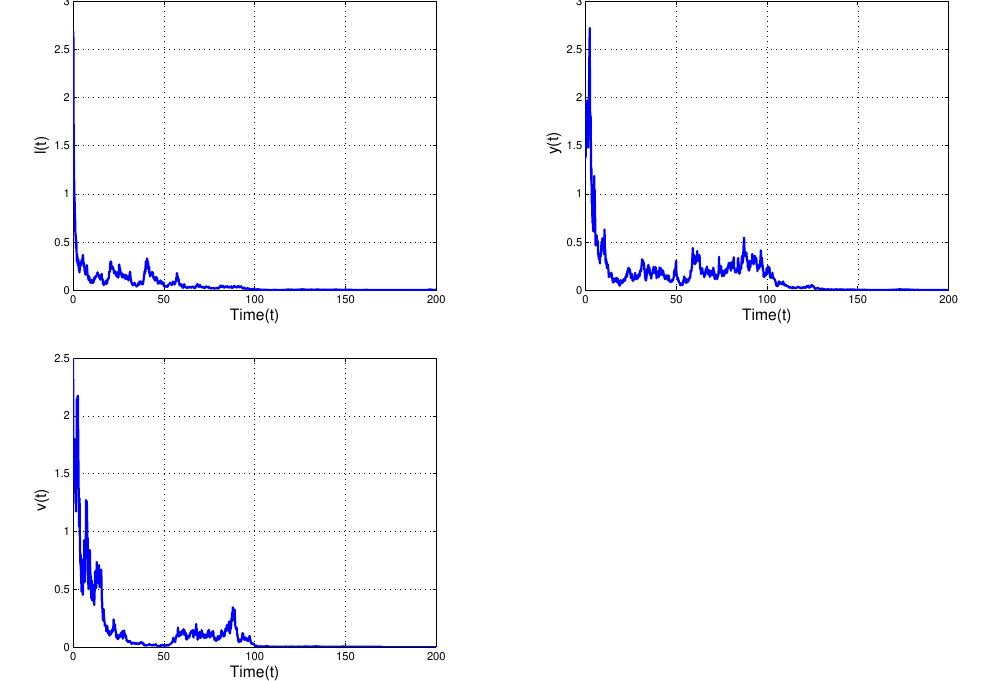
Figure 2. Shows time trajectories of l ( t ) , y ( t ) and v ( t ) of the stochastic model (2) with σ 1 = 3.9, = 0.5665 < 1. The stochastic noise is shown to suppress σ 2 = 3.9, σ 3 = 3.7, σ 4 = 3.9, σ 5 = 3.8 and ˜ R s 0 the explosion of